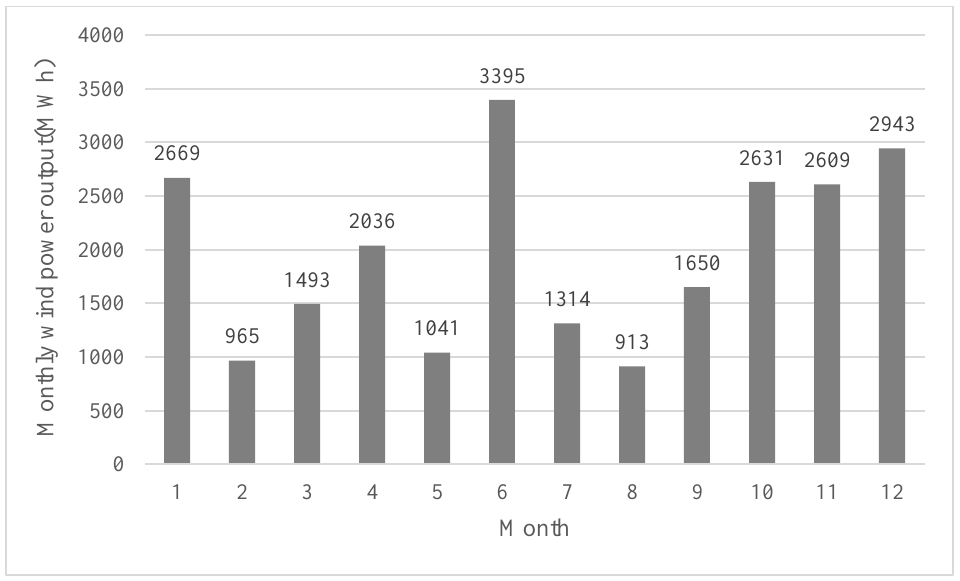
Figure 4. Monthly wind power output from an ENERCON E-126 7.58 MW wind turbine in Pincher Creek, 2019.